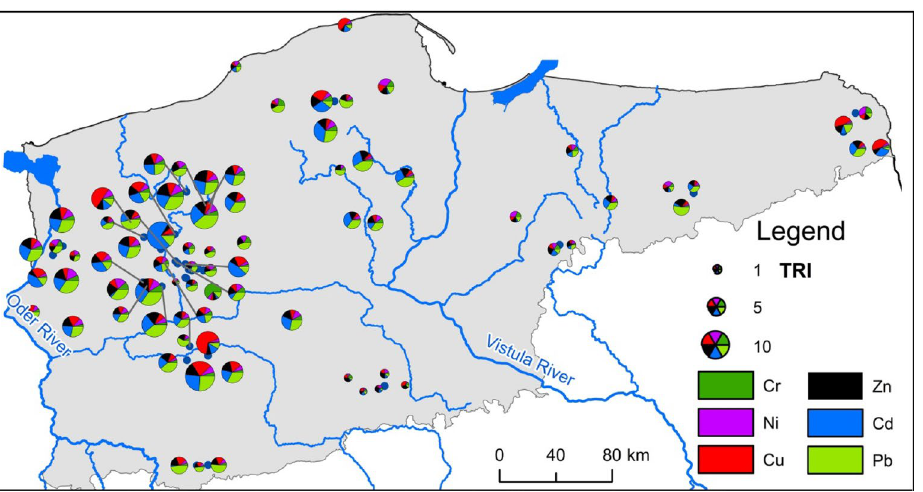
Figure 6. Potential ecotoxic effect of HMs accumulated in surface sediments of lakes (the figure was generated in ArcMap 10.7, https:// deskt op. arcgis. com/ en/